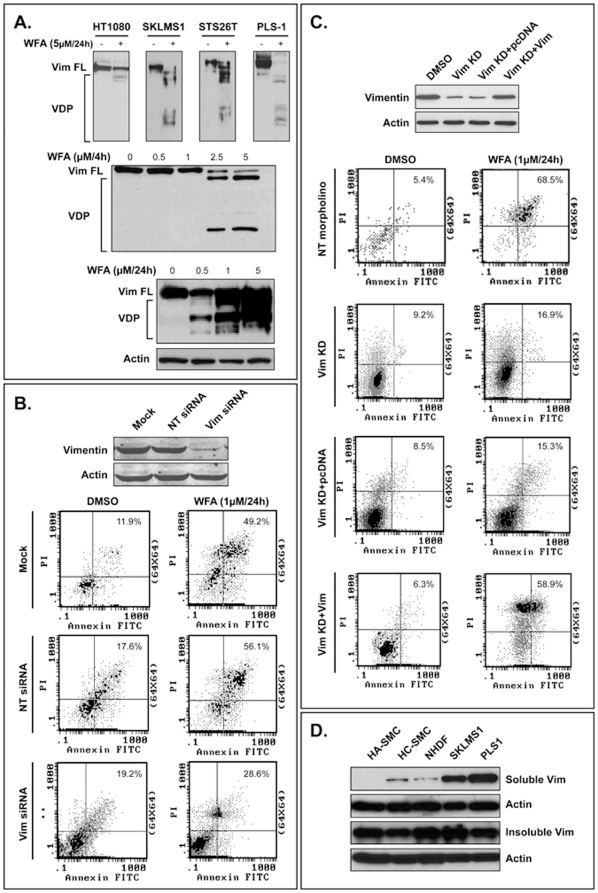
WFA induces vimentin degradation and vimentin knockdown decreases cells' sensitivity to WFA.
A) WFA treatment (5 µM/4 h) results in decreased full-length (FL) vimentin levels and increased expression of vimentin degradation products (VDP) in all STS cells tested. A WFA dose dependent effect in SKLMS1 cells treated for 4 h is also shown. Vimentin cleavage is noticed secondary to low WFA concentrations after 24 h of treatment; B) Anti-vimentin SMARTpool siRNA (20 nM) elicits a marked decrease in vimentin expression in SKLMS1 cells (WB). Vimentin knockdown substantially blocks WFA-induced (1 µM/24 hr) apoptosis; C) Endogenous vimentin was first knocked down in SKLMS1 cells using anti-vimentin antisense phosphorodiamidate morpholino oligomers. After knockdown, vimentin was forcefully re-expressed in the cells (WB). Similar to the results of siRNA knockdown, anti-vimentin morpholino oligomers significantly blocks WFA-induced (1 µM/24 hr) apoptosis. Re-expression of vimentin restores SKLMS1 sensitivity to WFA; D) STS cells (SKLMS1 and PLS1) express significantly higher levels of soluble vimentin as compared to normal mesenchymal cells (smooth muscle cells: HA-SMC and HC-SMC and fibroblasts: NHDF). (NT siRNA  =  non targeting siRNA, Vim siRNA  =  anti-vimentin siRNA smartpool; NT morpholino  =  non targeting morpholino; Vim KD  =  vimentin knockdown)